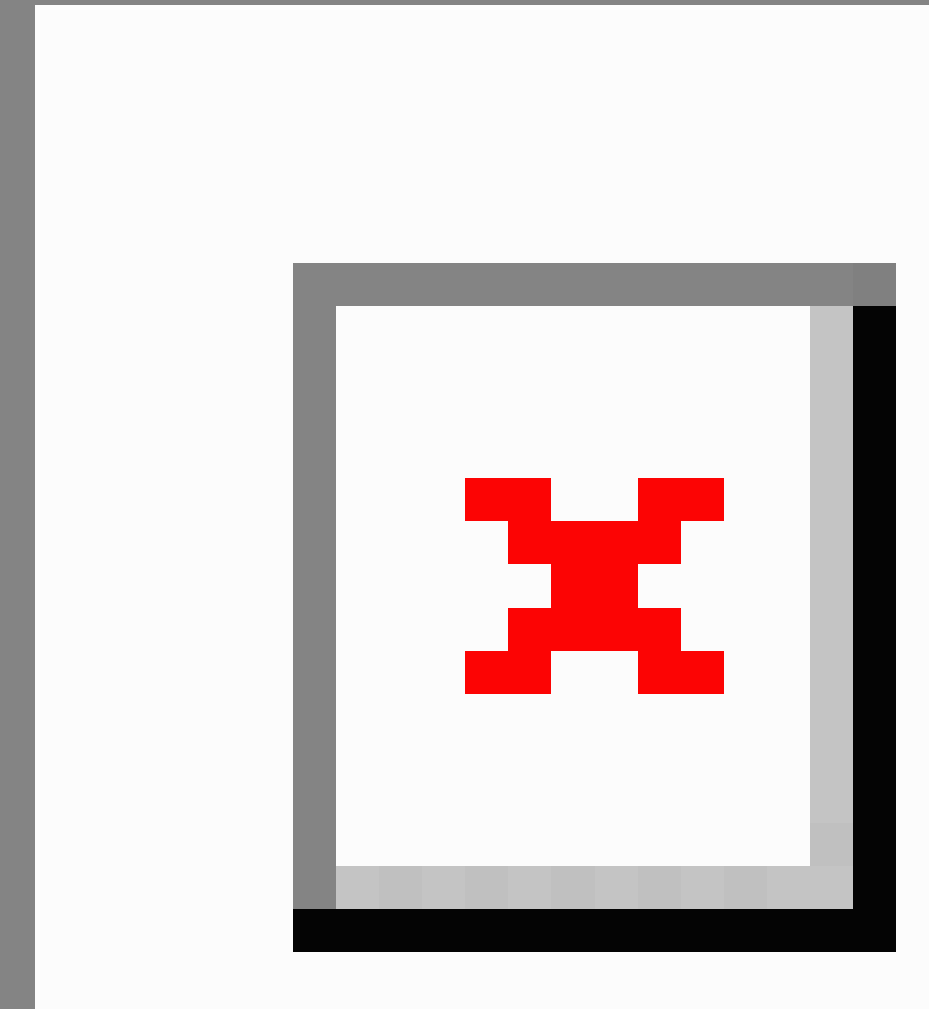
Figure 1. Video consultation